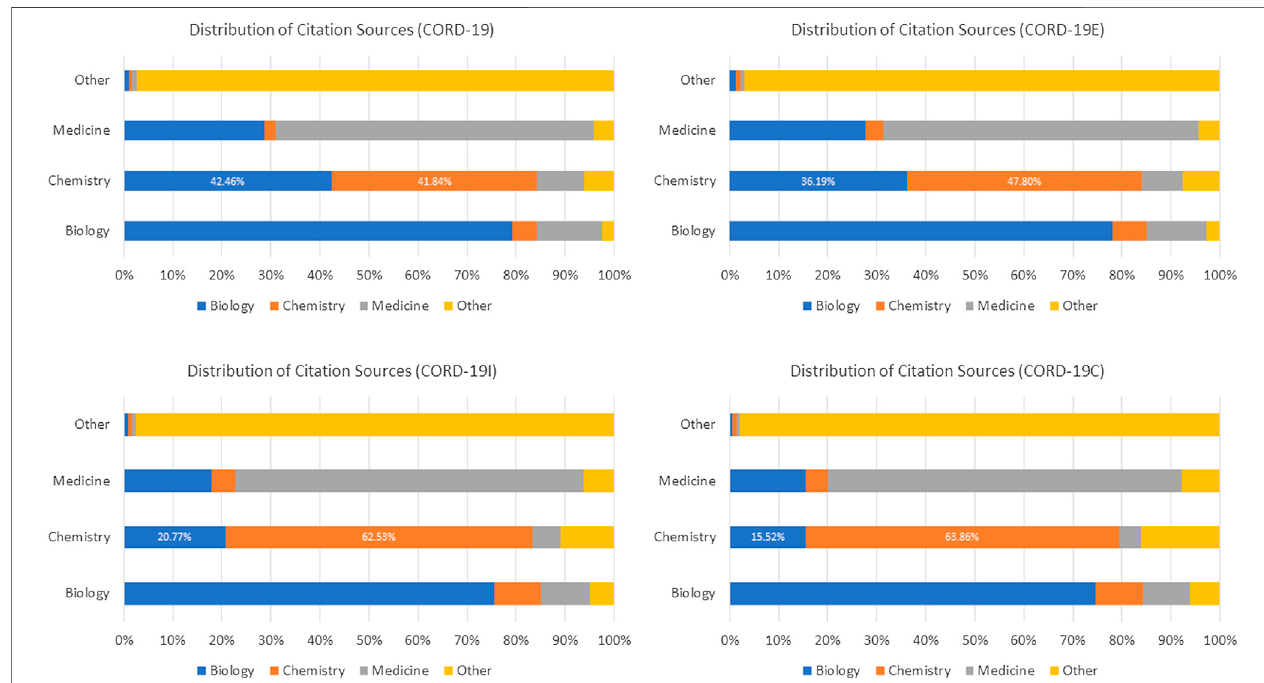
FIGURE 13| Percentage distributions of citations received for the top three fi elds in COVID-19 Research Dataset (CORD-19) and its expanded sets. In contrast to Figure 12 that computes the distributions based on the outgoing references, the statistics based on incoming citations shown here are distorted more seriously by the lack of coverage of chemistry articles in CORD-19: for example, one would conclude chemistry articles are cited more by articles of biology than of the same fi eld that cannot be corroborated by the expanded sets.